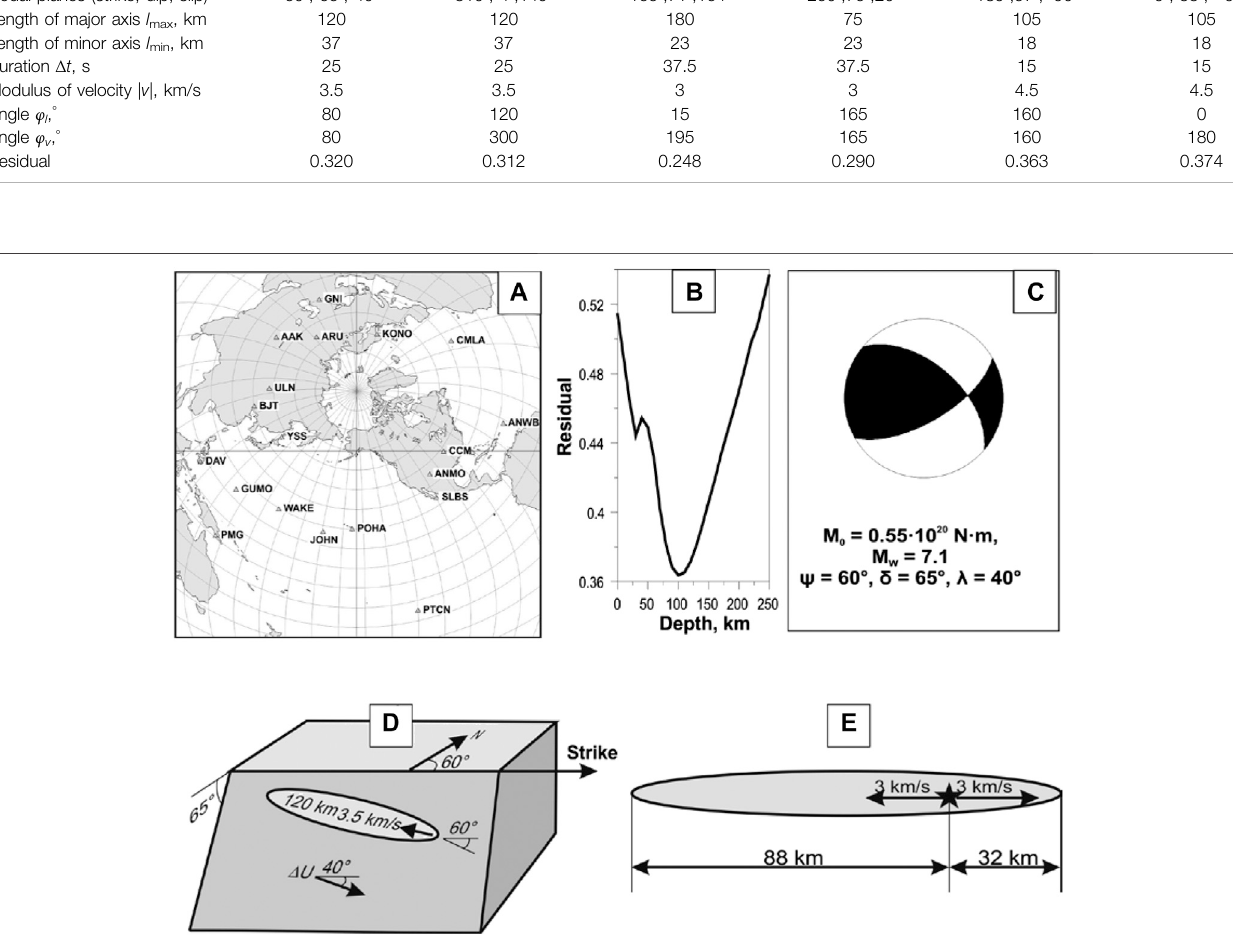
Frontiers in Earth Science |